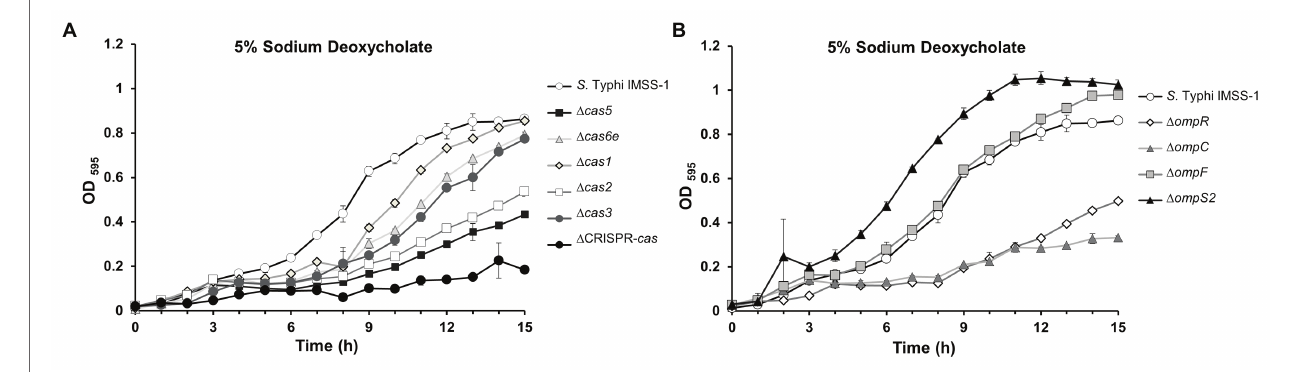
FIGURE 5 | The CRISPR-Cas system is required for resistance to the bile salt sodium deoxycholate in Salmonella Typhi. (A) Growth kinetics in sodium deoxycholate of Salmonella Typhi IMSS-1 wild type (empty circle), Δ cas5 (black square), Δ cas6e (gray triangle), Δ cas1 (gray diamond), Δ cas2 (empty square), Δ cas3 (gray circle), and Δ CRISPR- cas (black circle). (B) Growth kinetics in sodium deoxycholate of Salmonella Typhi IMSS-1 wild type (empty circle), Δ ompR (empty diamond), Δ ompC (gray triangle), Δ ompF (gray square), and Δ ompS2 (black triangle). For both kinetics, the bacterial strains were grown in LB broth supplemented with 5% sodium deoxycholate at 37 ° C. The growth was monitored by OD 595 . Three independent experiments were performed in duplicate and representative data are shown.